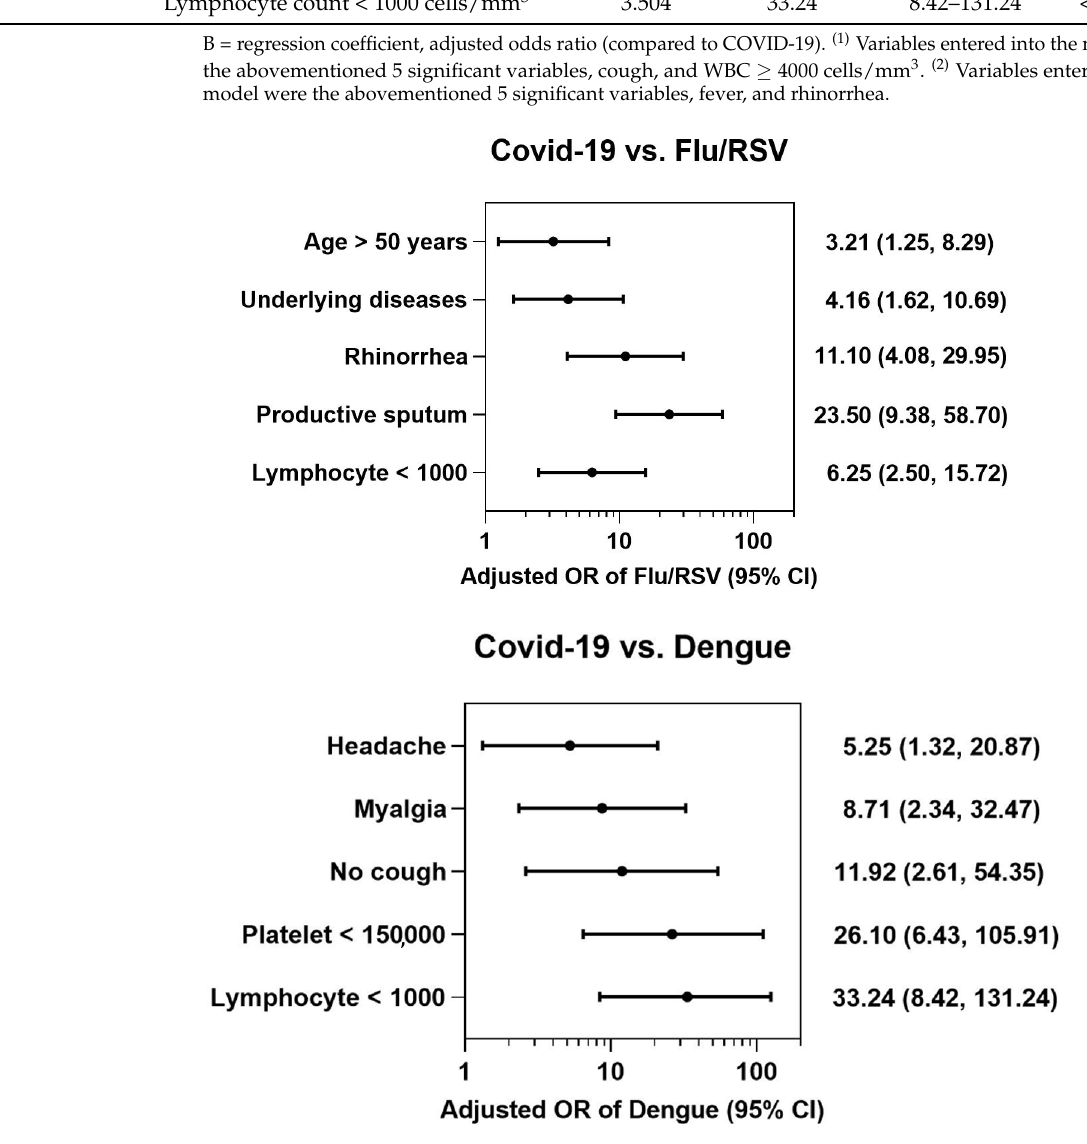
Figure 1. Multivariate logistic regression model of clinical and laboratory parameters for distinguishing between influenza / RSV or dengue and COVID-19 . An odds ratio ( OR ) > 1 is predictive of influenza/RSV or dengue .